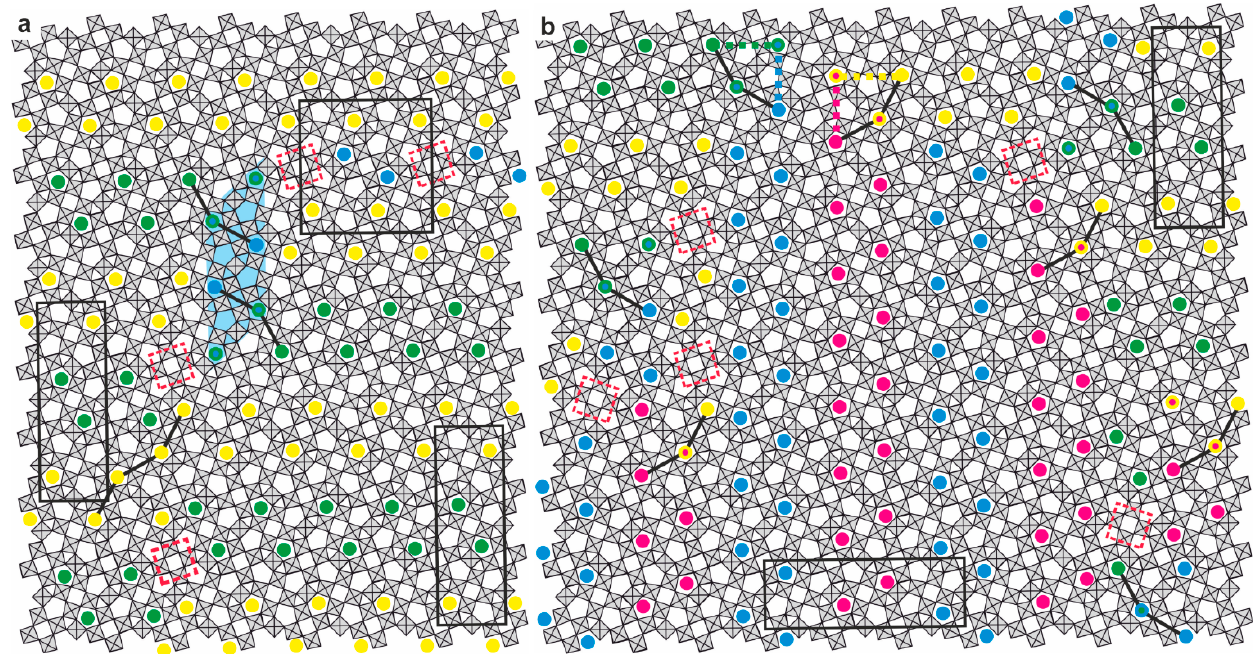
Figure 4. Structural models of the area ( a ) in the lower left corner and ( b ) in the upper right of Figure 3a. Some unit cells of Nb 8 W 9 O 47 and Nb 12 W 11 O 63 are framed black, and TTB subcells with four empty PTs are dotted red. In the lower part of ( a ), a grain boundary is present between domains of the Nb 8 W 9 O 47 , which are shifted by 1/3 b with respect to each other. In ( b ) domains of Nb 8 W 9 O 47 are rotated by 90°.